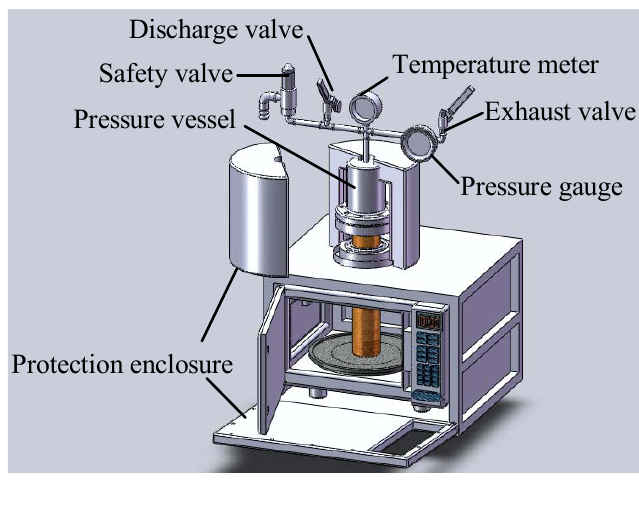
Figure 1. Microwave-based heating device and measuring